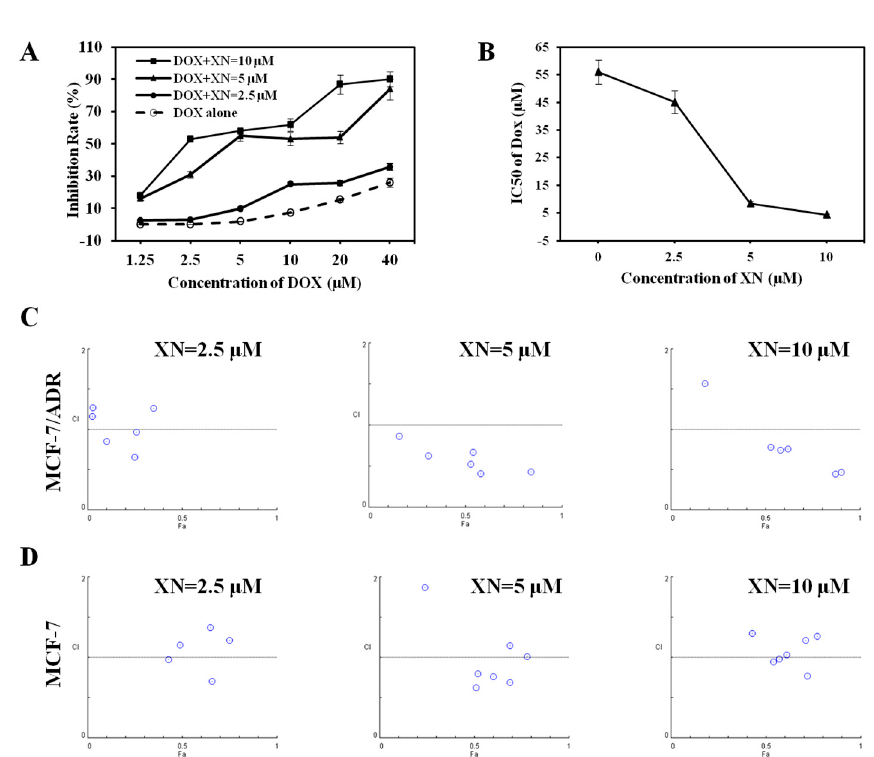
Figure 3. XN sensitizes the cytotoxicity of DOX in MCF-7/ADR cells. ( A ) MCF-7/ADR cells were treated with DOX in the absence and presence of increasing XN concentrations (2.5, 5, and 10 μ M). After treatment of 72 h, the cells viability was analyzed by MTT assay; ( B ) XN decreases the IC 50 values of DOX against MCF-7/ADR cells. Cells were treated with DOX for 72 h in the presence of 2.5, 5, and 10 μ M XN and the IC 50 values of DOX were calculated, respectively; ( C ) the Chou and Talalay CI analysis of synergistic effects with DOX. MCF-7/ADR cells were treated with DOX (0–40 μ M) in the presence of XN (2.5, 5, and 10 μ M) for 72 h; ( D ) The Chou and Talalay CI analysis of synergistic effects with DOX. MCF-7 cells were treated with DOX (0–10 μ M) in the presence of XN (2.5, 5, and 10 μ M) for 72 h.